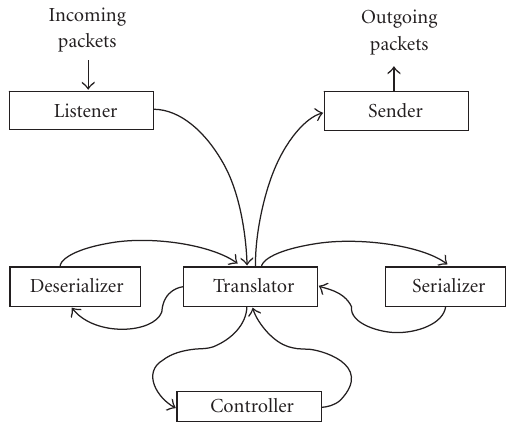
Figure 8: Functional components of a